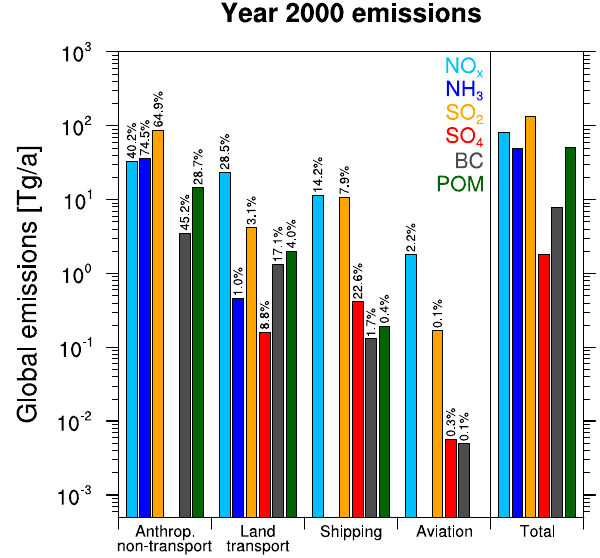
Fig. 1. Global emissions in the year 2000 for the anthropogenic sec- tors. The relative contribution to the total (including biomass burn- ing and natural sources which are not shown here) is given on top of each bar. Units are Tg ( species ) a − 1 and Tg ( NO ) a − 1 for NO x